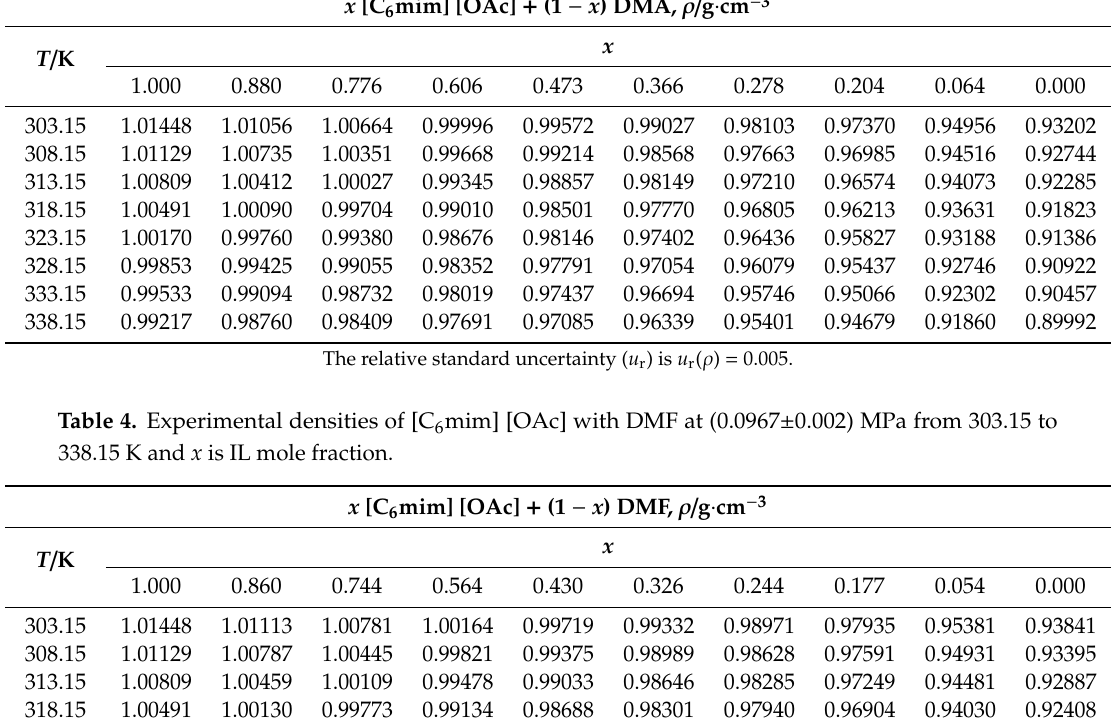
Table 3. Experimental densities of [C 6 mim] [OAc] with dimethylacetamide (DMA) at (0.0967 ± 0.002) MPa from 303.15 to 338.15 K and x is IL mole fraction.